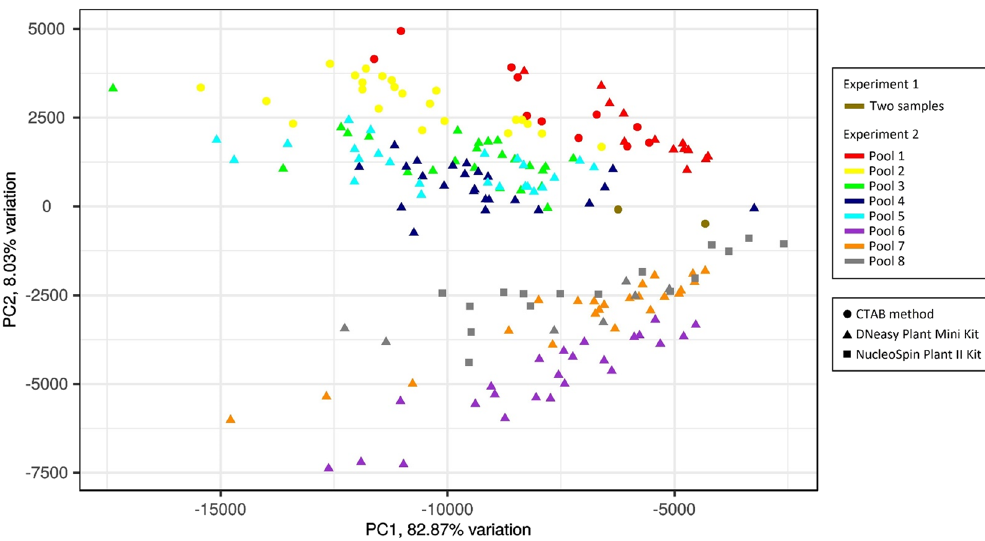
Figure 5. Principal Component Analysis of the number of read mapped on 1 K bins. Samples are codified with different colors according to the batch of analysis (Experiment 1 with two samples, and Experiment 2 with Pool 1–8) and shaped according to the DNA extraction